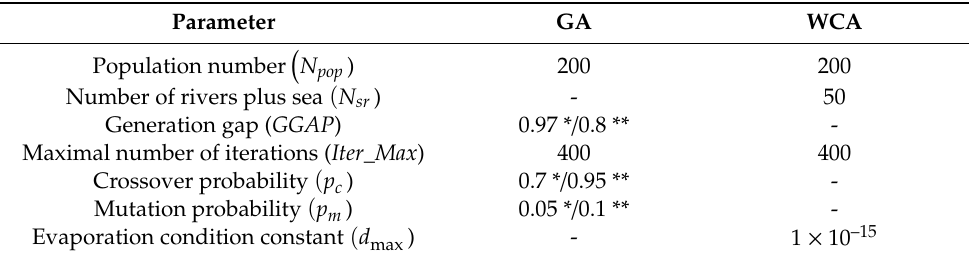
Table 1. GA and WCA parameters.